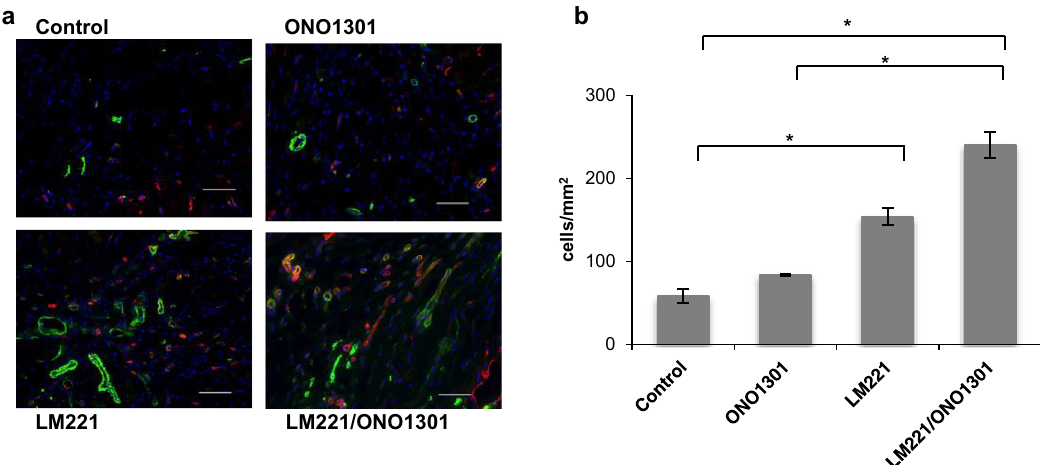
Figure 5. Combined administration of LM221 and ONO1301 increased mature capillary density. Some ILB4- positive cells in the implanted site were coated with SMA-positive cells, as observed by immunohistochemical analysis. ILB4 and SMA double-positive cells increased following the combined administration of LM221 and ONO1301. Representative microscopic images show ILB4 (red), SMA (green), and nuclei (blue). Scale bar = 50 μm. The graph indicates the number of ILB4 and SMA double-positive cells at the implanted site. * p < 0.05.